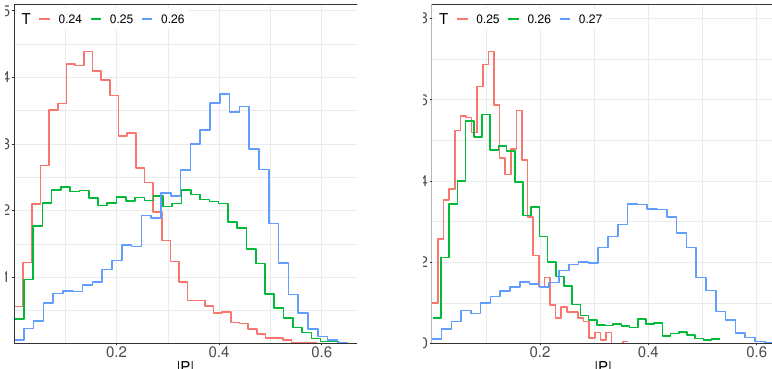
Figure 21. Full BMN model: histogram of P close to the critical temperature for µ = 0 . 8 , N = 12 , L = 12 (left); N = 12 , L = 24 (right). A blurred two-state signal is observed. A consistent signal with lower statistics has been observed also for N = 8 , L = 36 ; N = 8 , L = 48 , confirming the trend of the critical temperature to slightly increase in the continuum limit.